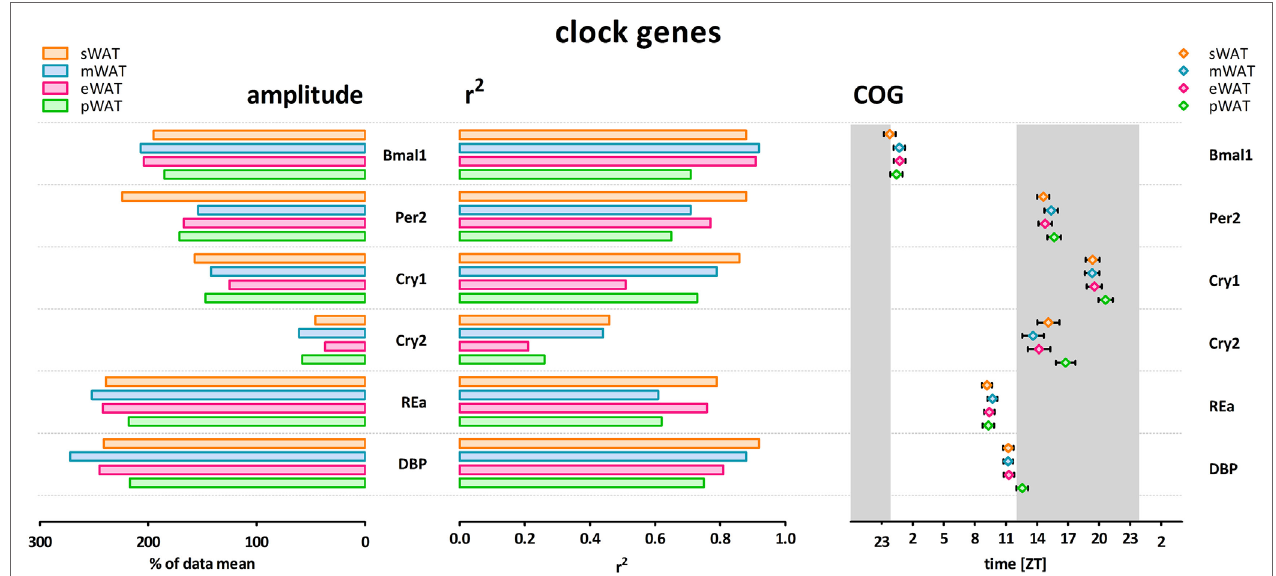
FigUre 1 | Clock genes show high amplitude, high r 2 (low inter-individual variability) and low variability in center of gravity (COG) in subcutaneous and intra- abdominal white adipose tissue (WAT) depots. sWAT, subcutaneous; mWAT, mesenteric; eWAT, epididymal; pWAT, perirenal. Gray bars indicate the dark phase (ZT 12–24). Individual expression curves for each gene and WAT depot can be found in Figure S1 in Supplementary